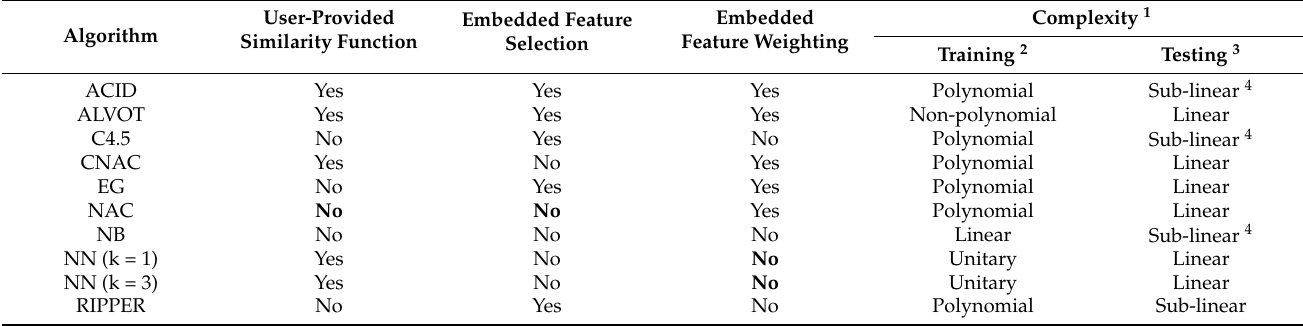
Table 5. Qualitative comparison of the proposed CNAC vs. the compared supervised classifiers.